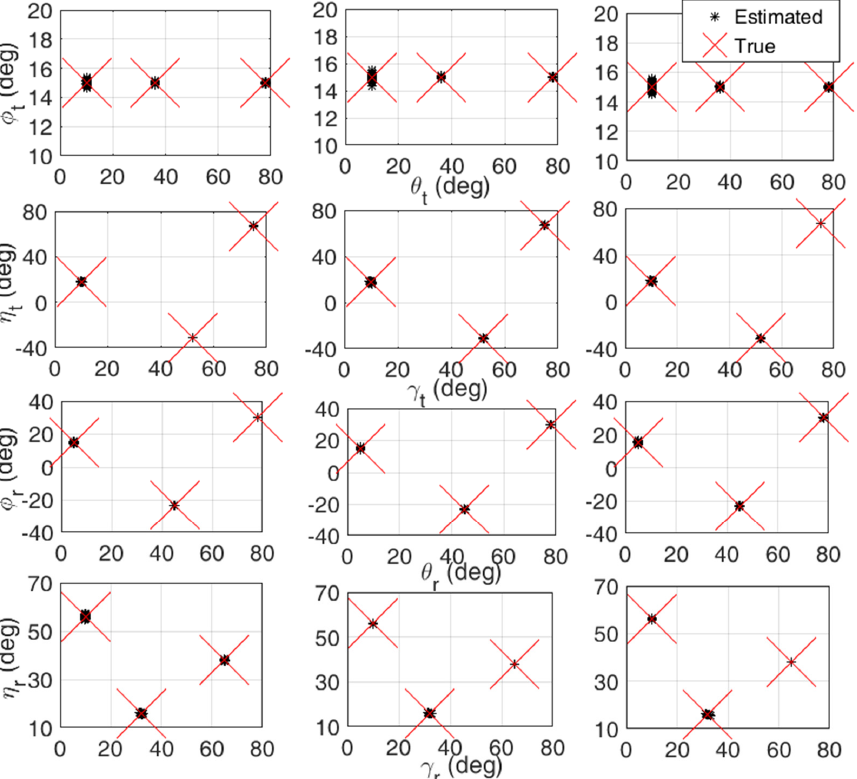
Figure 2. Scatter results of the proposed approaches for complete coherent targets in Case ( I ). ( left ) T-TS approach, ( Middle ) T-RS approach, and ( Right ) T-TRS approach. Example 2. RMSE of the proposed approaches versus SNR. Figure 3 gives the average RMSE on direction (2D-DOD and 2D-DOA) estimation and polarization (2D-TPA and 2D-RPA) estimation versus SNR comparison for 3 K = completely coherent targets in Case (I), where